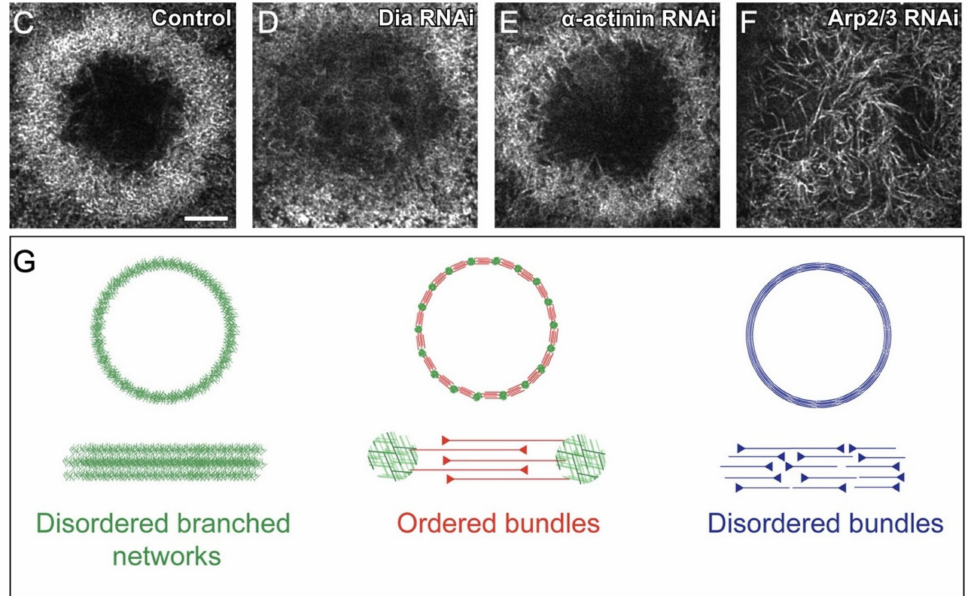
Figure 4. Branched and linear nucleation factors are crucial for cell wound repair. ( A ) Schematic diagram depicting crucial factors for stabilizing and nucleating linear actin filaments. Formins add actin monomers to the pointed end of the actin filament, whereas crosslinkers aid in bundling linear filaments. ( B ) Schematic diagram depicting branched filament assembly via the Arp2/3 complex and WAS family proteins. ( C – F ) XY super-resolution view of actin ring organization at 70% percent wound closure in control cell wounds showing a dense actin mesh circumscribing the wound ( C ), Diaphanous RNAi knockdowns (disrupting linear actin formation) exhibit a diffuse mesh of branched actin at the wound periphery ( D ), alpha-actinin RNAi knockdowns (an actin crosslinker needed for actin bundling) form a more sparse ring at the wound edge compared to that at control wounds ( E ), and Arp 2/3 RNAi knockdowns (disrupting branched actin formation) do not form an actin ring at the wound periphery, but rather have unusually long linear actin filaments within the wound ( F ). Scale bar: 5 µ m. ( G ) Schematic diagram depicting different types of actin architectures. Reprinted from Ennomani et al., (2016), Curr. Biol. 26(5): 616–626. doi: 10.1016/j.cub.2015.12.069 [60], with permission from